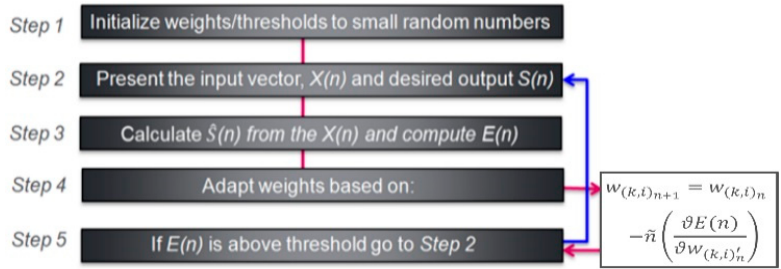
Figure 4. Steps required in the ANN training process [17,18].